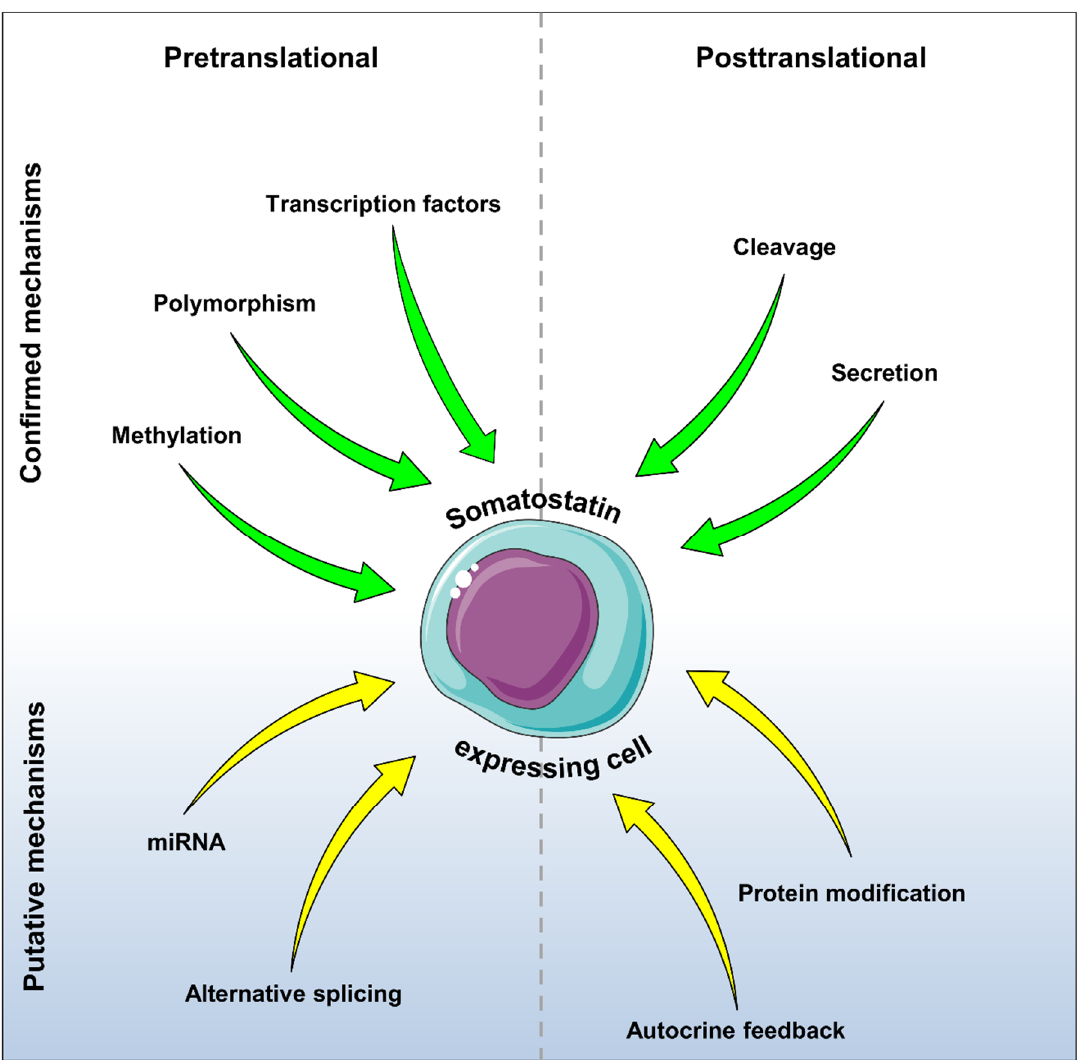
Figure 3. The regulatory mechanisms of somatostatin expression. It is known that the cellular somatostatin content is pretranslationally regulated by methylations and polymorphisms within the promoter region as well as by the activity of different transcription factors (green arrows). On the posttranslational level, the cellular somatostatin content is regulated by proteolytic cleavage of pre-prosomatostatin into somatostatin (SS-14 and SS-28) and by secretion (green arrows). Further putative factors and mechanisms, which may regulate the expression of the peptide hormone, are miRNAs, alternative splicing, autocrine feedback, and protein modification (yellow arrows).